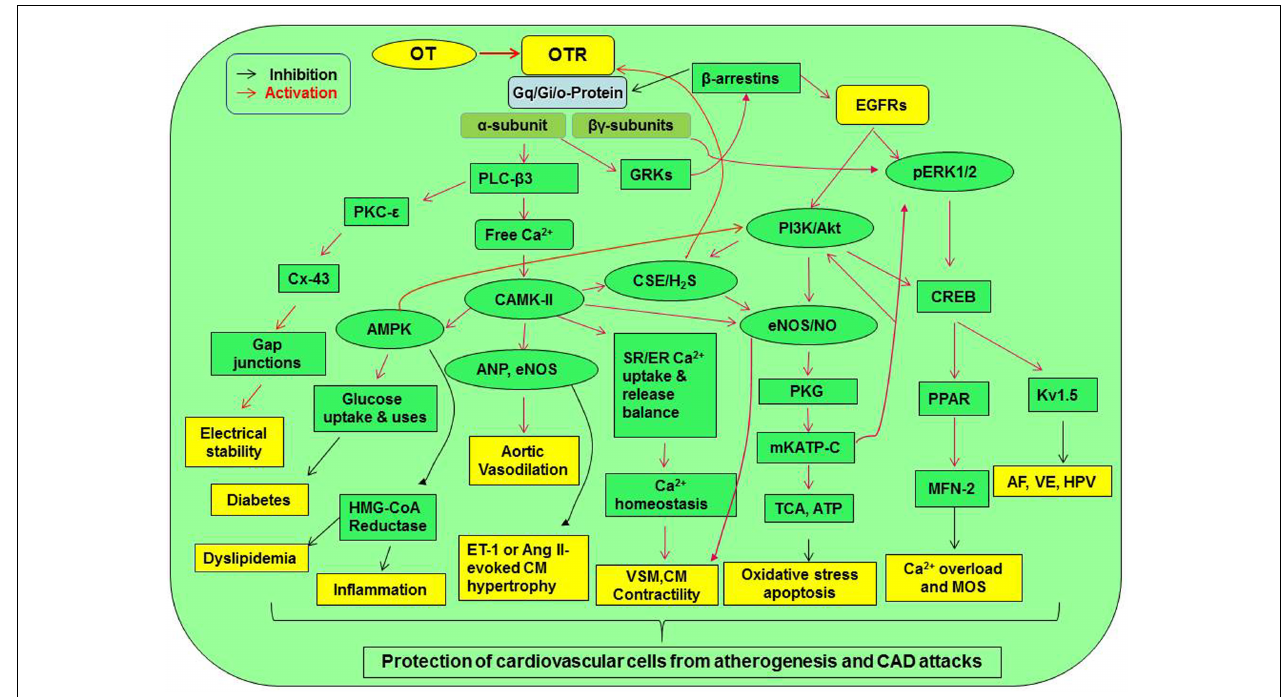
FIGURE 2 | Signaling pathway mediating cardiovascular protection of OT. Activation of OTR-Gq and Gi/o proteins can directly increase Gq α subunit and G βγ subunit signaling. These signals can cross-activate EGFR while activating their downstream signaling molecules, resulting in the activation of CaMK-AMPK, PKC- ε , PI3K/Akt-eNOS, H 2 S, and ERK1/2-CREB signaling cascades. These signaling cascades lead to the activation of a variety of cardioprotective functions including electrical stability, metabolic arrangement, inhibition of inflammation or oxidative stress, and others. AF, atrial fibrillation; Akt, protein kinase B; AMPK, AMP-activated protein kinase; Ang, angiotensin; CaMK, Ca 2 + /calmodulin-dependent protein kinase; CREB, cyclic AMP response element-binding protein; CSE, cystathionine- γ -lyase; Cx-43, connexin-43; EGFR, epidermal growth factor receptor; eNOS, endothelial nitric oxide synthase; ER, endoplasmic reticulum; ERK1/2, extracellular signal-regulated protein kinase 1/2; ET-1, endothelin-1; GRK, G protein-coupled receptor kinase; HMG-CoA reductase, 3-hydroxy-3-methyl-glutaryl-coenzyme A reductase; HPV, hypoxic pulmonary vasoconstriction; H 2 S, hydrogen sulfate; Kv1.5, voltage-gated potassium channel Kv1.5; MFN-2, mitofusin-2; mKATP C, mitochondrial ATP-dependent potassium channels; MOS, mitochondrial oxidative stress; PI3K, phosphatidylinositol 3-kinases; PKC, protein kinase C; PKG, protein kinase G; PLC- β 3, phospholipase C- β 3; PPAR, peroxisome proliferator-activated receptor; SR, sarcoplasmic reticulum; TCA cycle, tricarboxylic acid cycle; VSM, vascular smooth muscle; VE, ventricular ectopy. Other annotations refer to Figure 1